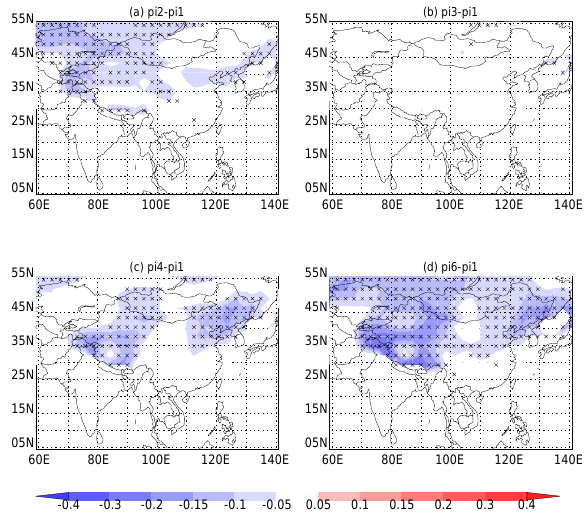
Fig. 10. Same as Fig. 8 but for snow cover fraction (SCF,